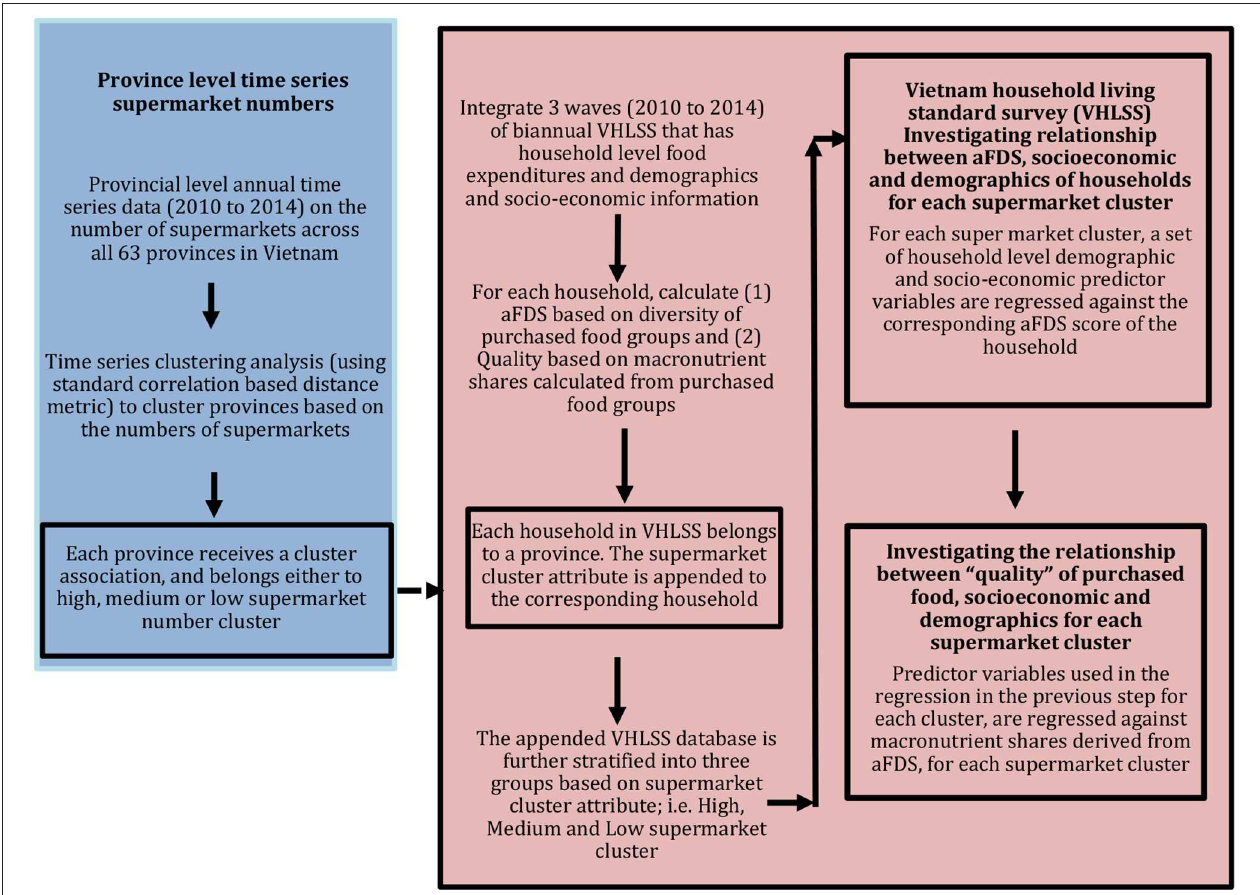
FIGURE 1 | A data analysis strategy that facilitates interoperability of two independent data sets was implemented, which are the province level time series data on supermarket numbers (in the blue colored box), and the Vietnam household living standard survey (in orange colored box). The blue box represents steps taken for time series clustering and statistical analysis of supermarket numbers and the identified clusters, while the orange box describes calculation of the response variables, i.e., aFDS and derived quality indices (i.e., Household macronutrient share of acquired food groups), and the regression strategies used to estimate relationship between the response variables and socioeconomic, demographic characteristics of the household. The dashed line connecting the two boxes indicates the step at which supermarket cluster information was appended to the VHLSS data